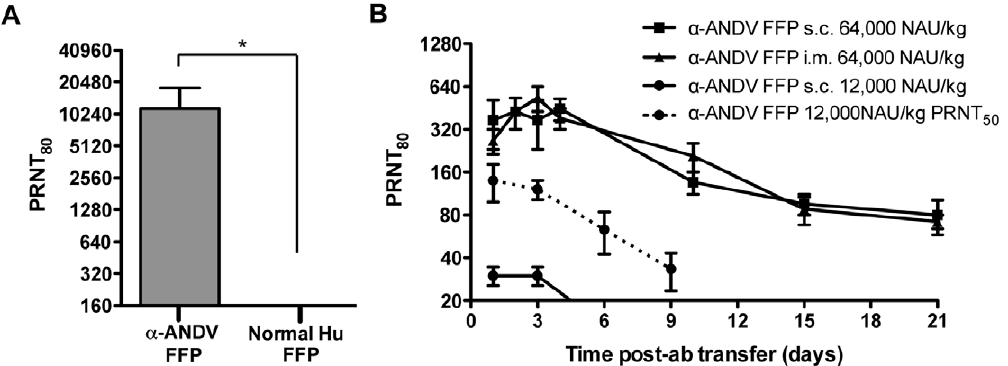
Figure 1. a -ANDV FFP effectively neutralizes ANDV invitro and is detectable in hamsters after passive transfer. A) Neutralizing antibody titers were determined by ANDV PRNT 80 performed on a -ANDV FFP and normal human serum. * indicates results are statistically significant. B) Neutralizing antibody bioavailability was determined by ANDV PRNT 80 performed on hamster serum samples collected after passive transfer of a - ANDV FFP (64,000 NAU/kg) by either s.c. or i.m. route (3 hamsters per group) on day 0, through 21 days. PRNT 80 titers represent the lowest serum